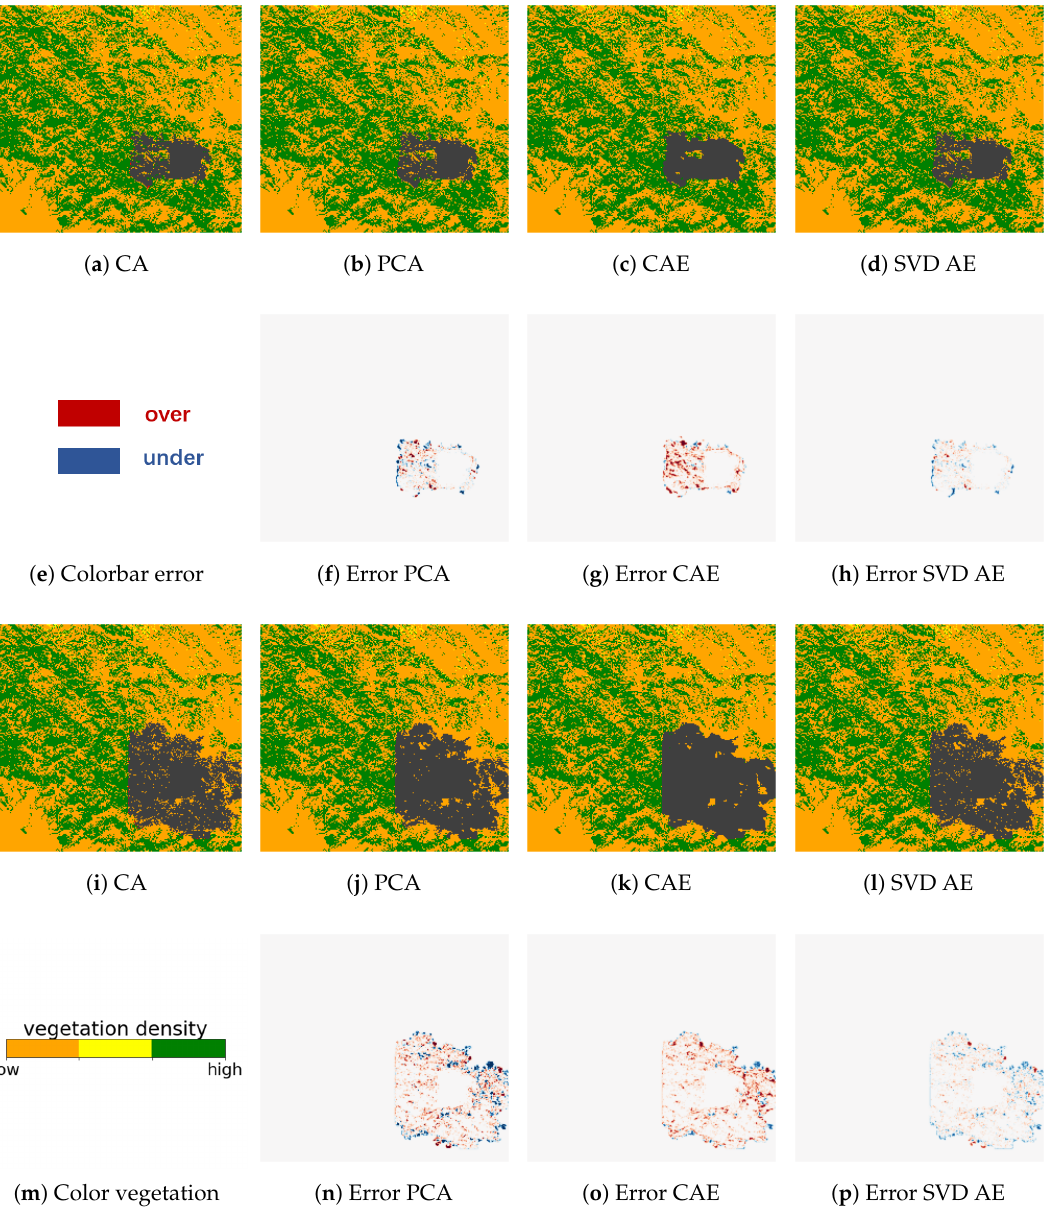
Figure 5. Reconstruction of CA simulations for 2 examples in the test dataset of the Chimney fire at day